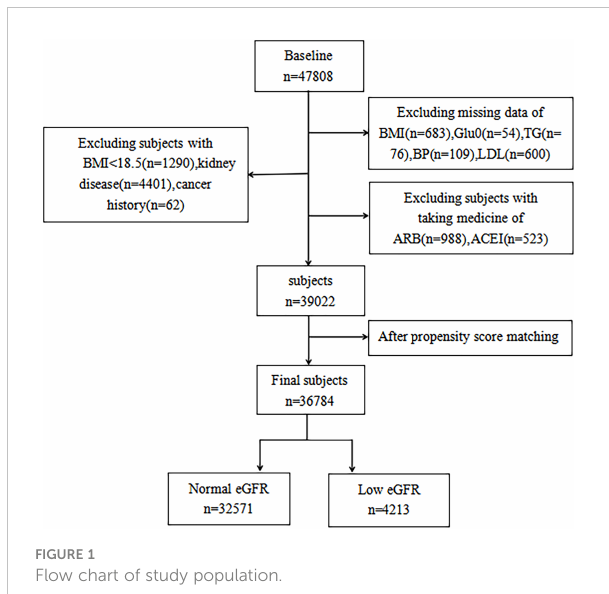
FIGURE 1 Flow chart of study